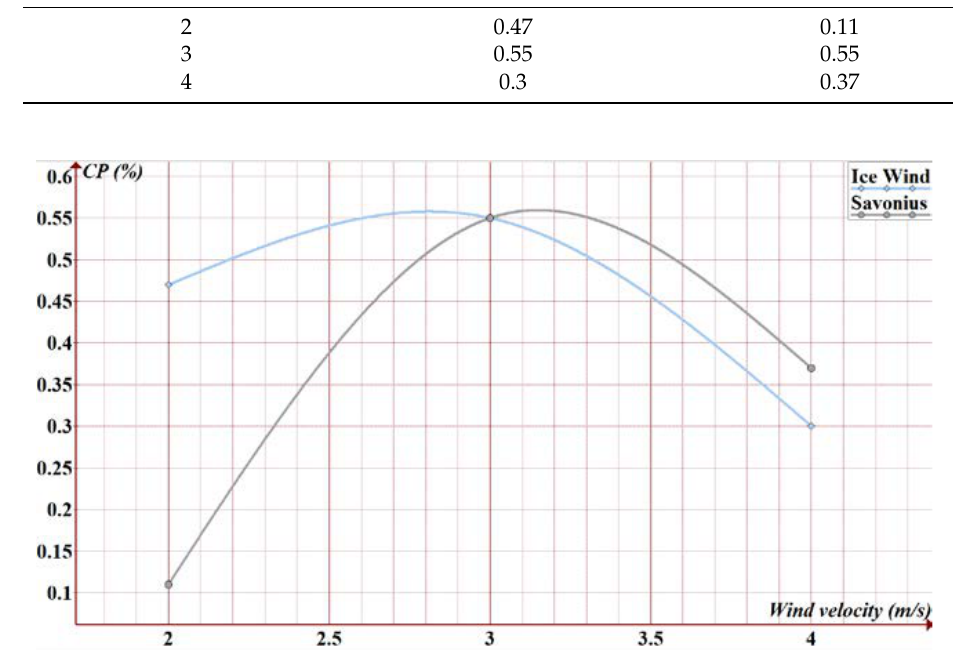
Figure 21. CP values for the Ice Wind roto versus the SAVONIUS rotor [87].